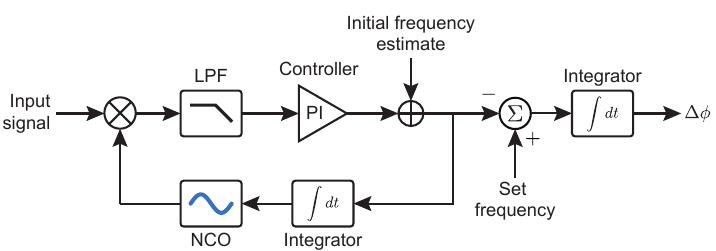
Figure 7. Modified phase-locked loop used to calculate phase error with respect to a desired offset frequency, f set